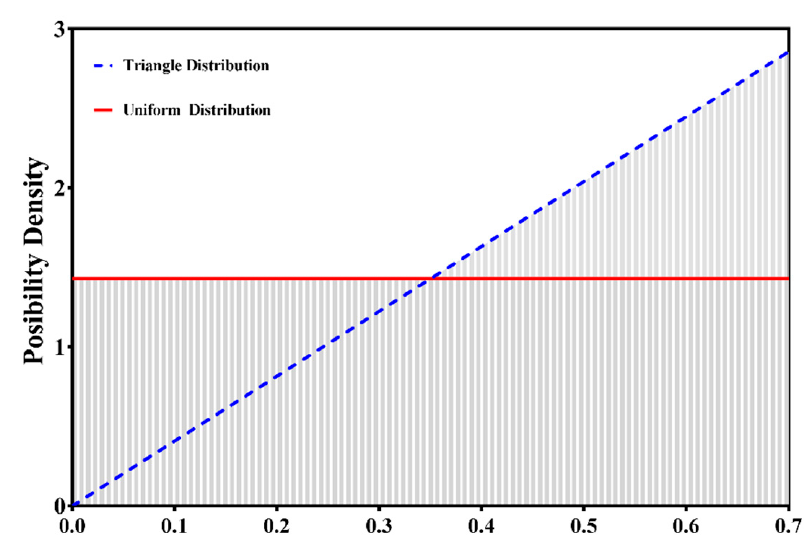
Figure 12. Roughness bands location probability distribution.